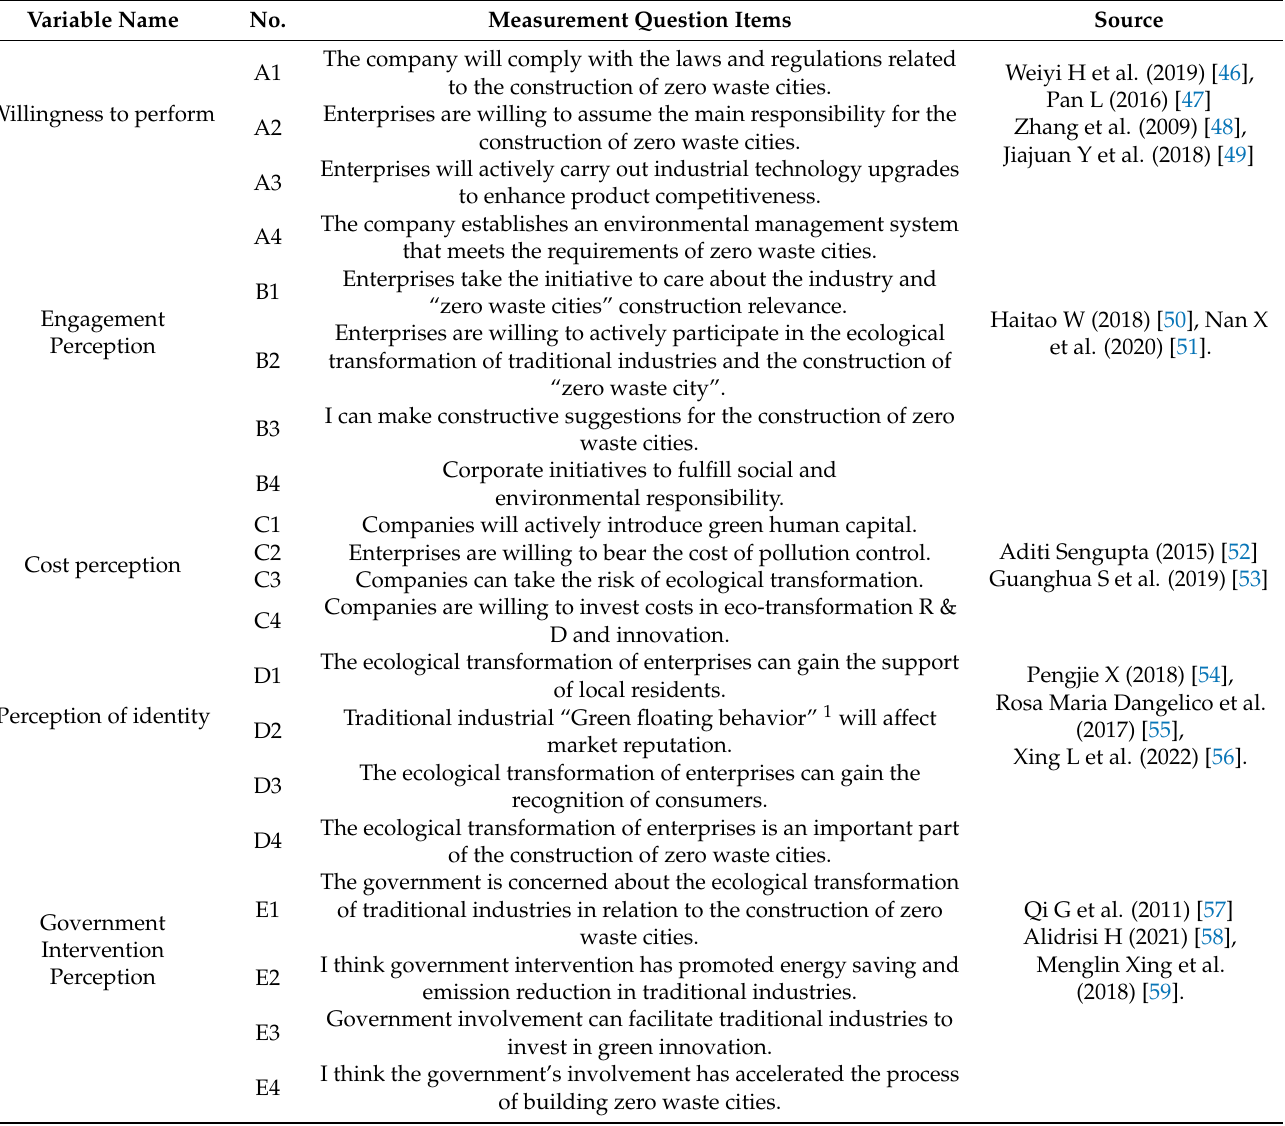
Table 1. Variable measurement